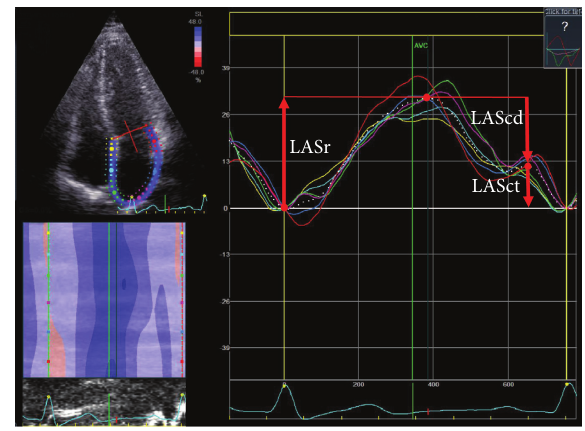
Figure 1: Measurements of left atrial strain parameters with the zero strain reference at the